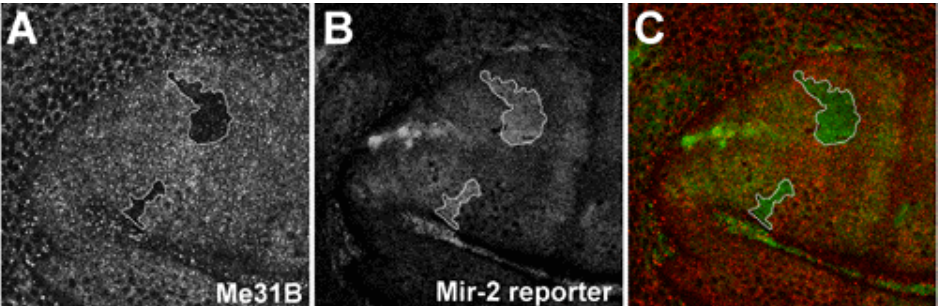
FIGURE 4. Me31B is required for the function of the endogenous microRNA mir-2. A mir-2 GFP-reporter[75] was used to measure the function of the endogenous miRNA mir-2. The up-regulation of GFP (B) in Me31B homozygous mutant clones (marked by the loss of Me31B expression, A) indicates that Me31B is required for the mir-2– dependent repression of GFP. In these experiments, mitotic recombination clones were induced by the FRT/FLP system, 48 ± 2 h after egg lay (AEL) by heat shock at 37ºC for 90 min; larval genotype used: hsFLP; Me31B D1, FRT 40/FRT 40, arm-lacZ; mir2-reporter/+ . Wing discs were dissected 120 ± 2 h AEL, fixed with 4% formaldehyde and double stained with α -Me31B[43] and α -GFP (Molecular